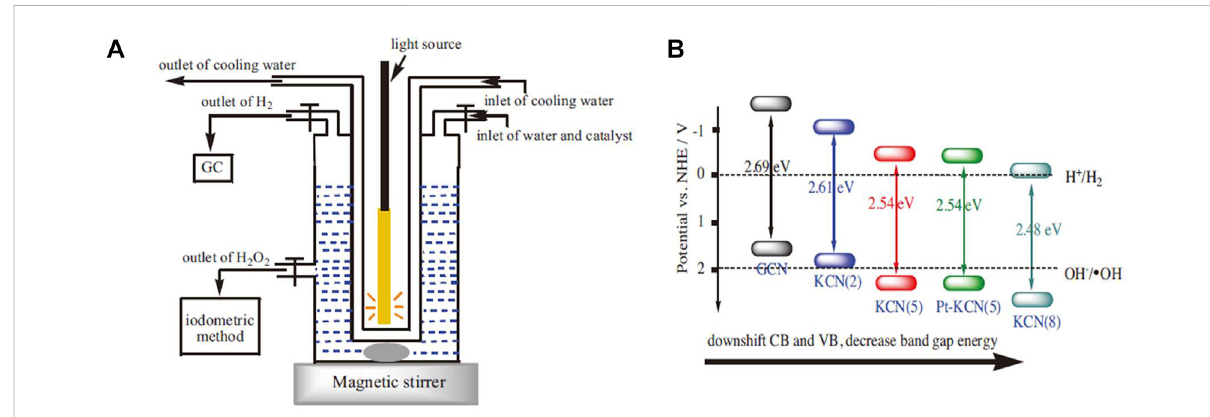
FIGURE 5 (A) The schematic diagram of the reactor. (B) The band position of K + /g-C 3 N 4 (Hu et al.,